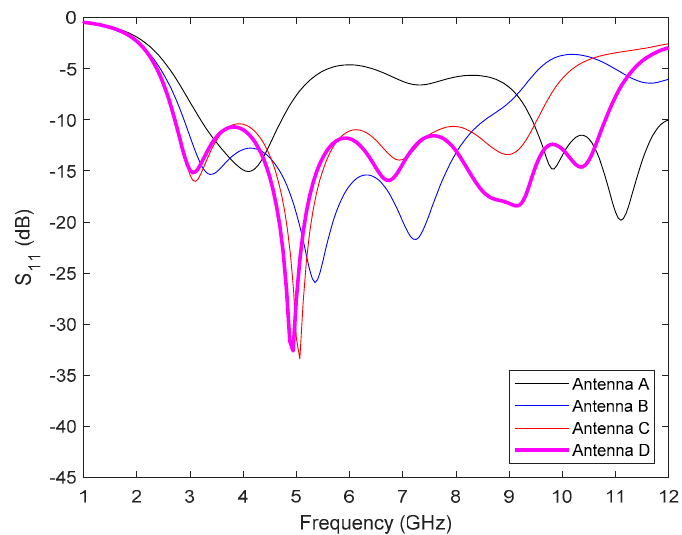
Figure 7. Results for the different phases followed in the antenna design.